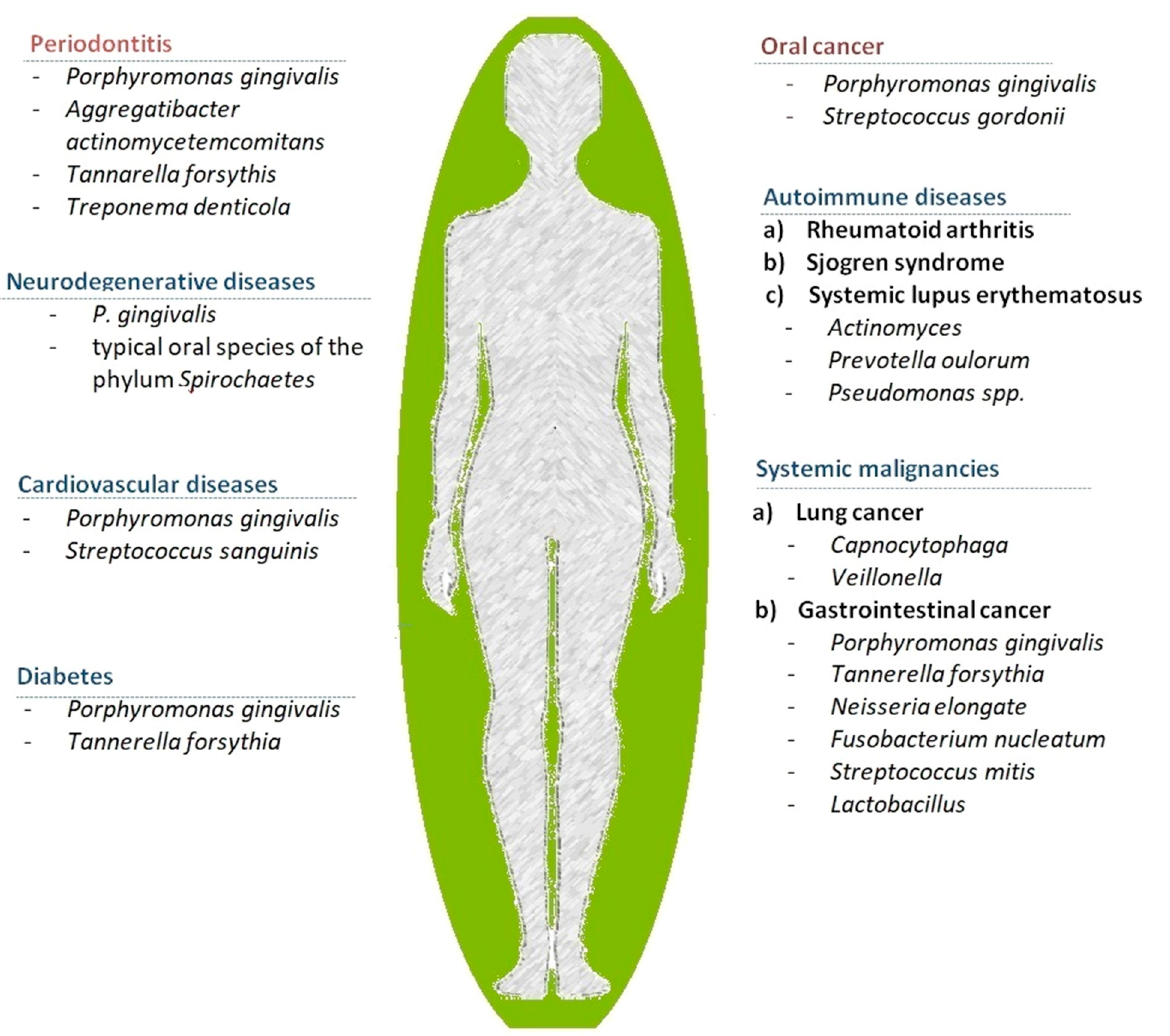
Figure 4. Types of main oral and main systemic diseases related to dysbiosis of the oral microbiome adapted after [6,30,43,44,63–65,69].